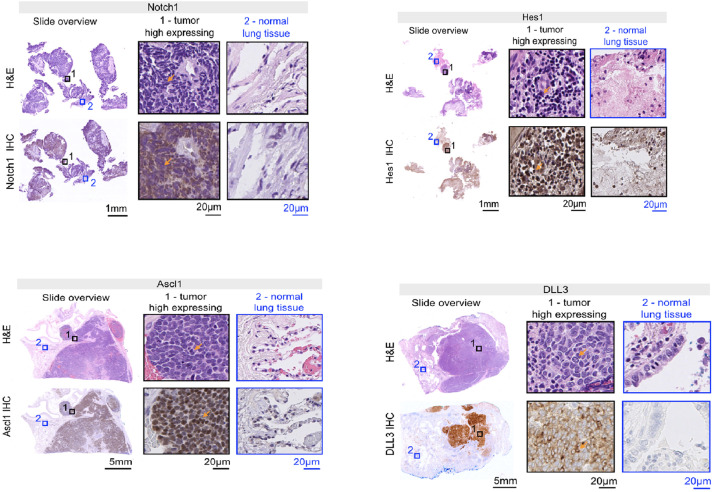
Expression of Notch1, Hes 1, Ascl1 and DLL3.Representative immunohistochemical staining’s. Left panel: overview of
the tumor biopsy (SCLC) with Hematoxylin and Eosin (HE) staining (top)
and the expression of the different biomarkers (bottom), Middle panel:
(1)–The localization of SCLC HE image (top), and the same area for high
expression of the biomarker in IHC (bottom). Right panel: (2)–Normal
lung tissue within the SCLC HE image (above), and the same are for the
biomarker expression (below). (A) Notch1, (B) Hes 1, (C) Ascl1 and (D)
DLL3. The arrows point at the representative SCLC cells in the HE images
(top) as well as each biomarker (below).